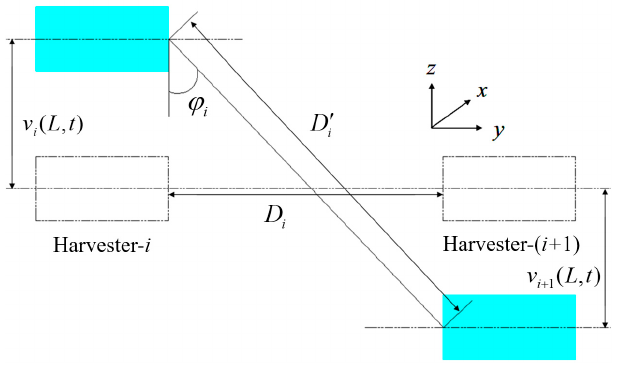
Figure 4. Relative geometrical position of two adjacent harvesters.